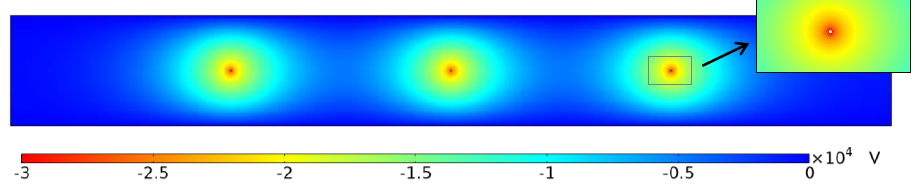
Figure 14. Electric potential contours in the ESS.